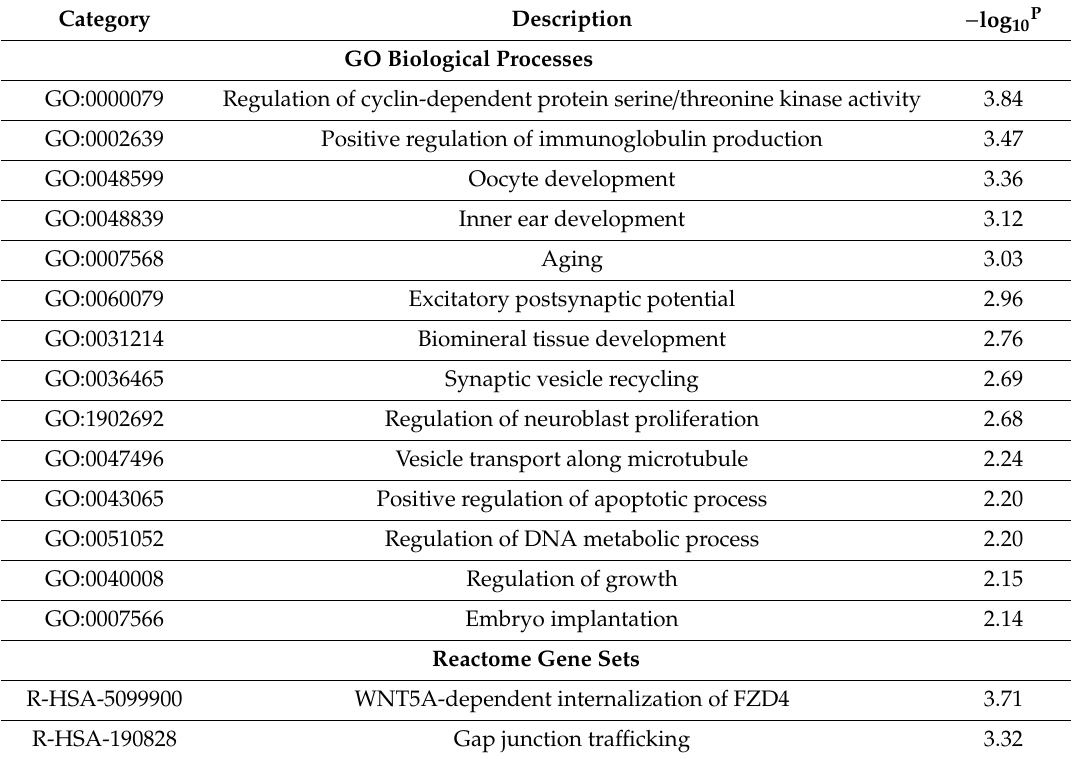
Table 3. Gene ontology (GO) term and Kyoto Encyclopedia of Genes and Genomes (KEGG)